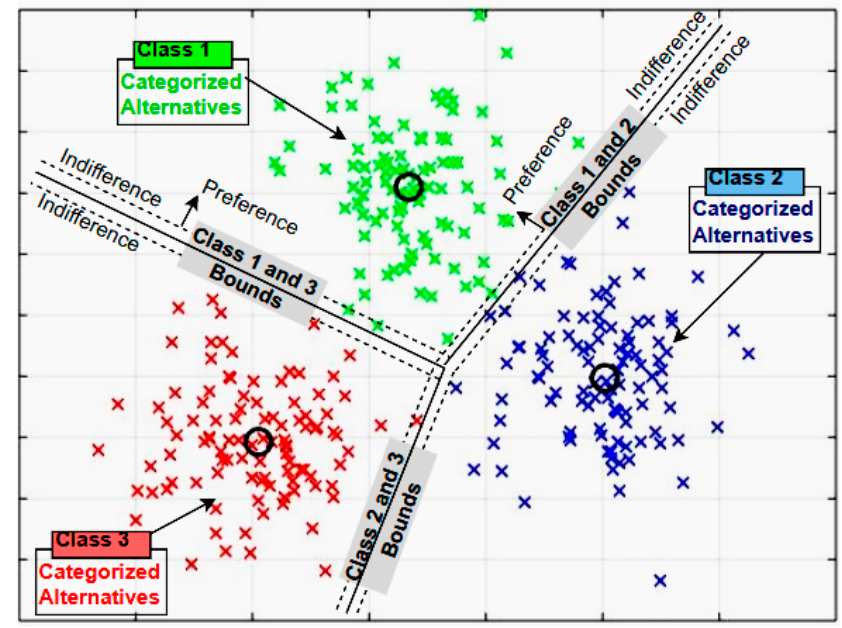
Figure 3. Partitional Clustering Procedure Illustration.